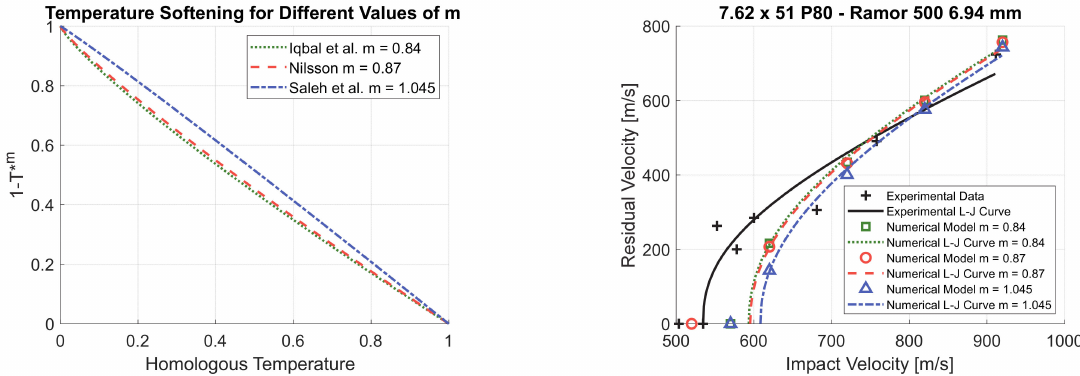
Figure 10. Temperature softening for different values of m ( a ) and m parametric study ( C = 0.001) ( b